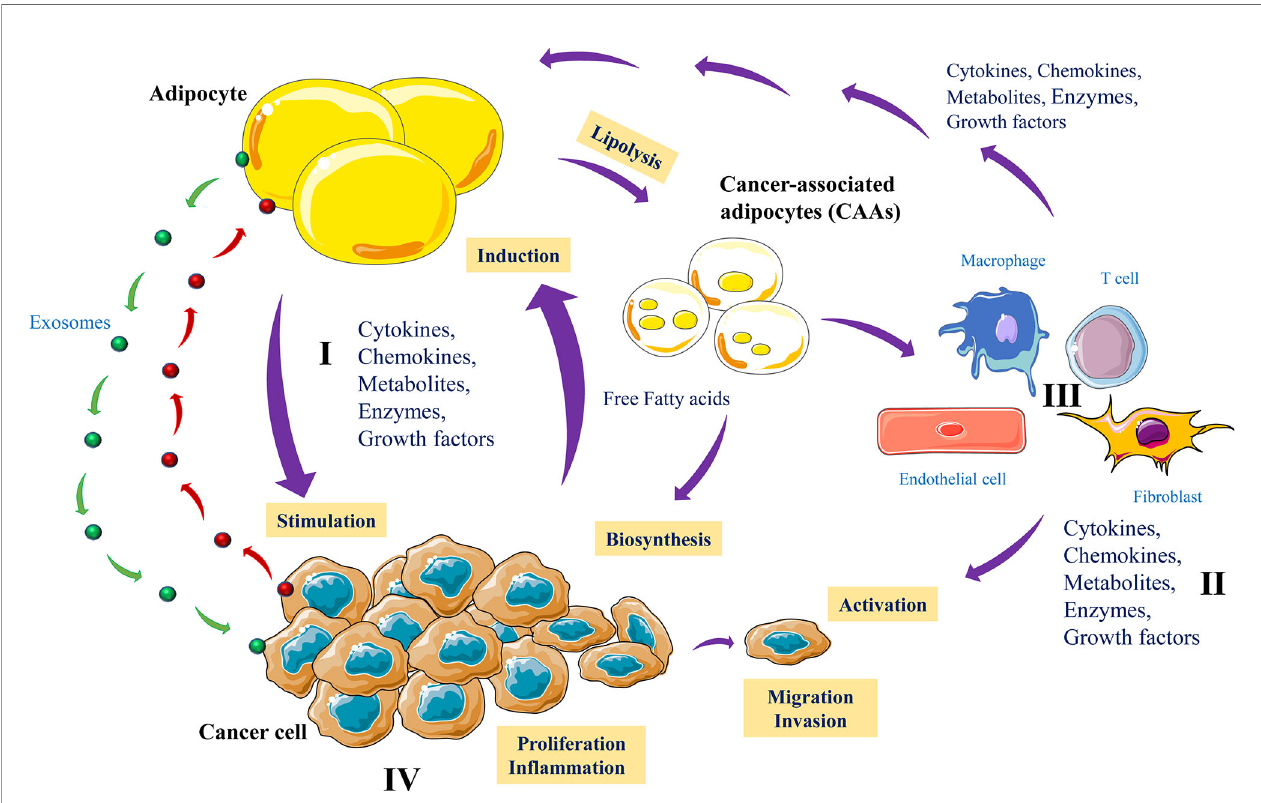
FIGURE 6 | Adipocytes and cancer cells communication. Cancer cells produce various mediators including exosomes to reprogram metabolic activity of adipocytes (I). In turn, cancer-associated adipocytes (CAAs) produce growth factors, cytokines, MMPs and release exosomes that directly affect tumor cell growth and invasion (II). Lipolysis activated by tumor cells reduced lipid droplets in adipocytes and the CAA products such as free fatty acids are used as energy fuel molecules to promote tumor growth, angiogenesis, in fl ammation and metastasis (III). In parallel, the adipocyte-derived factors activate various nontumor cells to control the malignant and metastatic phenotype of tumor cells